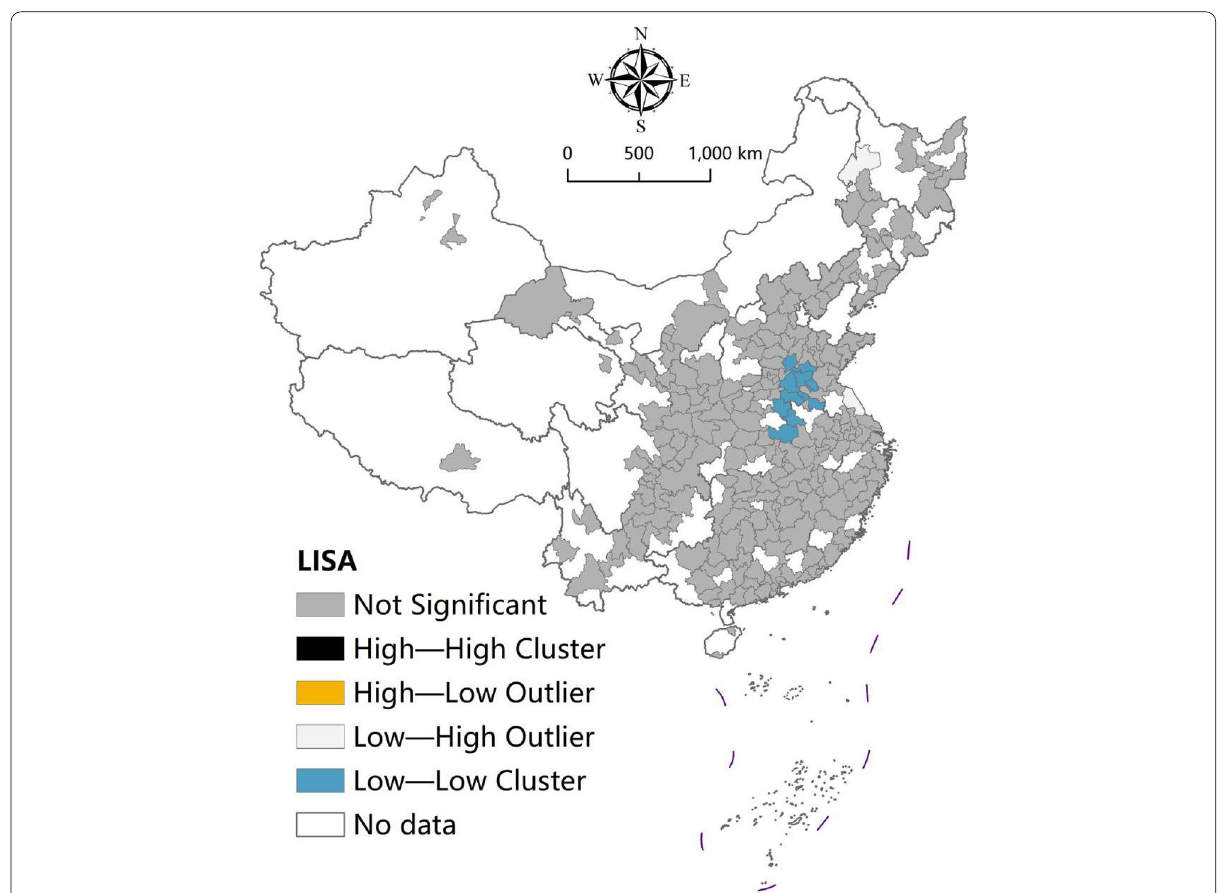
Fig. 4 LISA aggregation diagram of the net migration rate. Data source: China Migrants Dynamic Survey (CMDS;